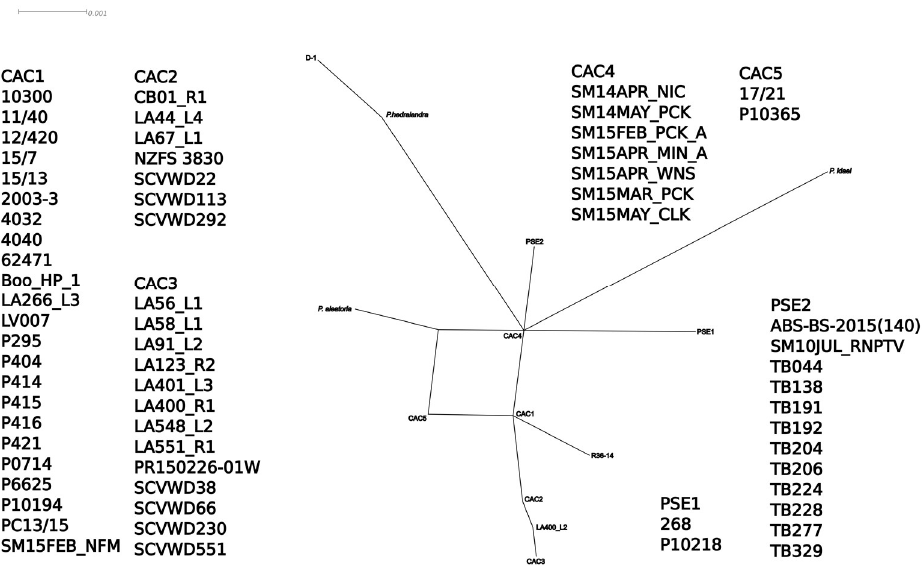
Figure 7. Split-decomposition network from ITS rDNA sequences of Phytophthora cactorum , P. pseudotsugae and other subclade 1a species. Accession information listed in Table S1. Figure created with SplitsTree4 and annotated with InkScape. Scale bar is split support for node connections.